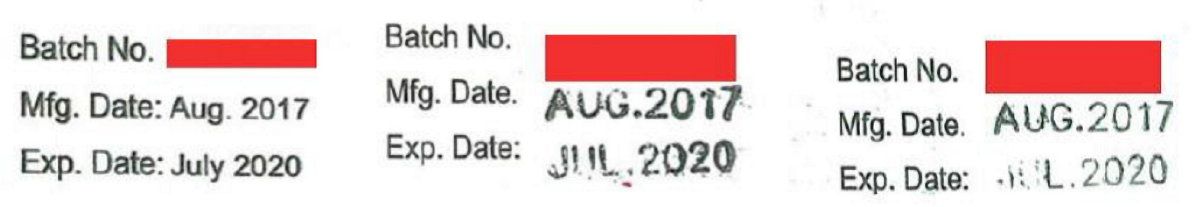
Fig 2. Labels of samples with same batch number but different text font and style.